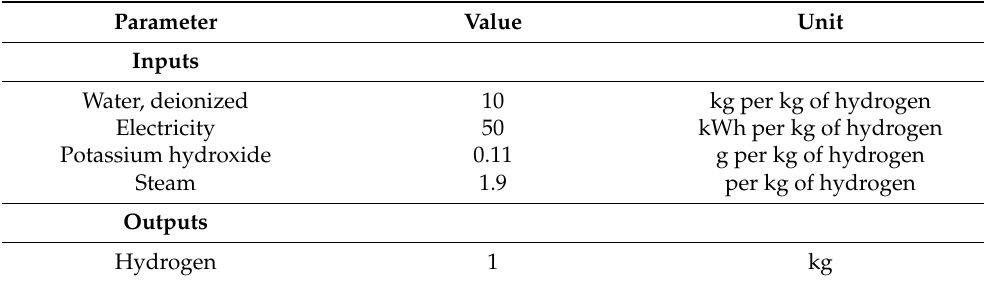
Table 7. Inventory of the hydrogen production unit.